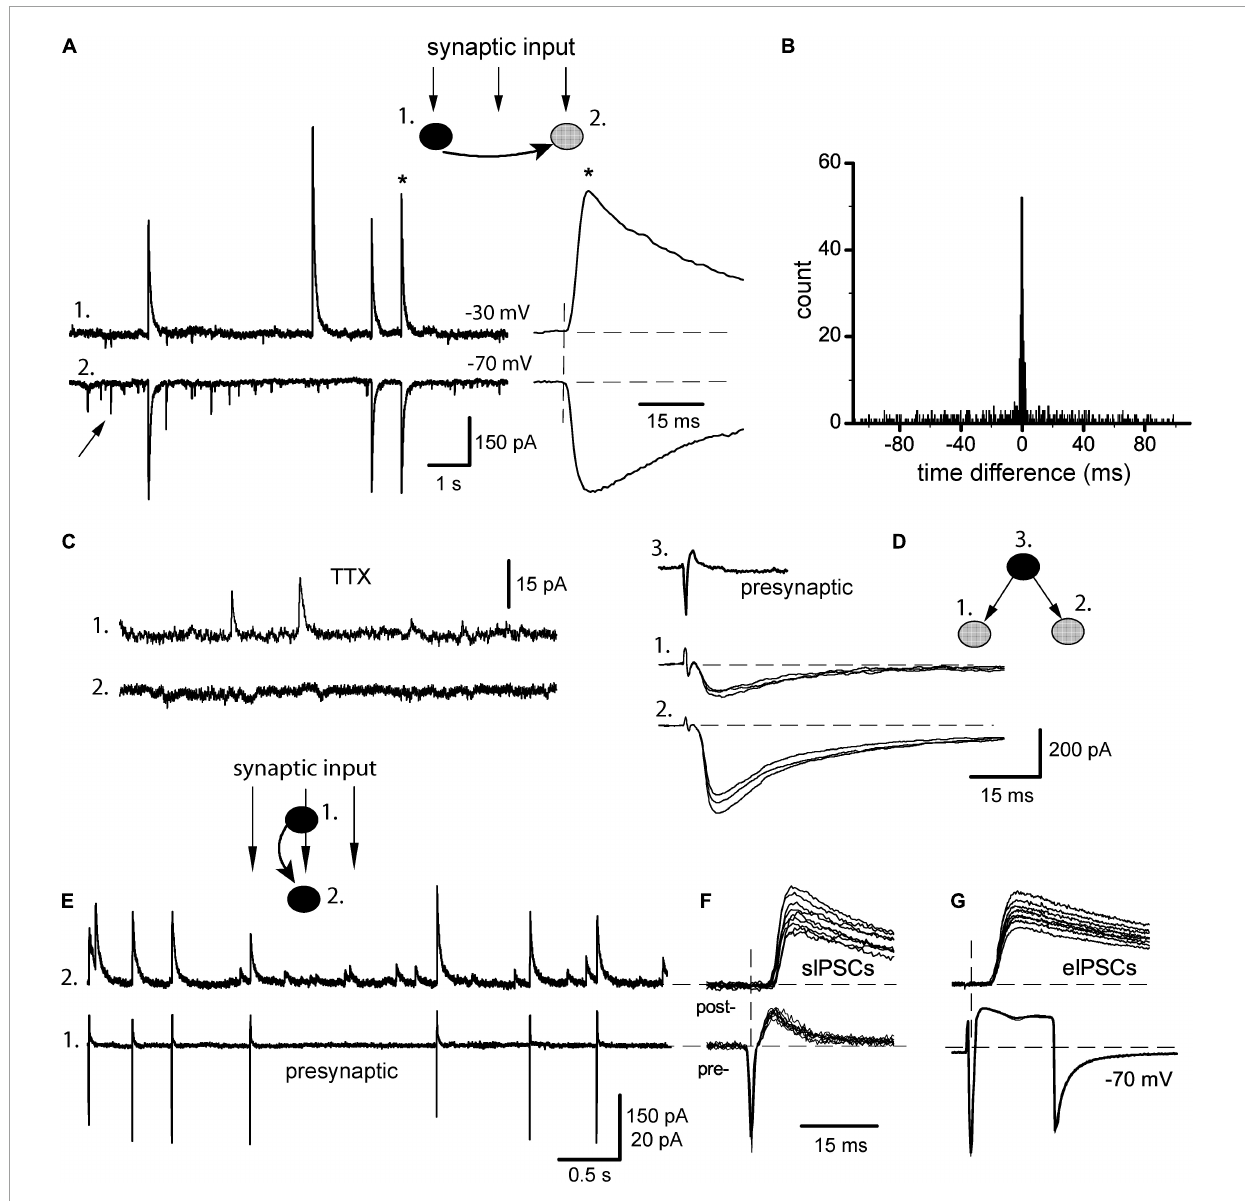
FIGURE2 Synchrony of baseline sIPSCs. (A) Classical pair recording of incoming synaptic input in a pair of IN-unidentified cells ( 1 and 2, respectively), from here and below the phenotype of each pair is shown on insets (filled circles: INs, gray: unidentified cells). Arrow points on sEPSC; one of the coupled sIPSCs (*) is expanded to the right. (B) Respective time difference histogram. (C) Application of 0.5 µ M TTX abolished synchrony of sIPSCs (same pair). (D) Stimulation of one presynaptic IN ( 3 ) evoked IPSCs in sequentially recorded neurons ( 1 , 2 ) showing the divergence of axons. (E) Identification of synaptic output of a given presynaptic neuron ( #1 , cell-attached mode) within a raw synaptic input impinging on postsynaptic neuron ( #2 , whole-cell mode). (F) Selection of APs-coupled sIPSCs. (G) Presynaptic stimulation with both neurons kept in whole-cell mode and recording unitary